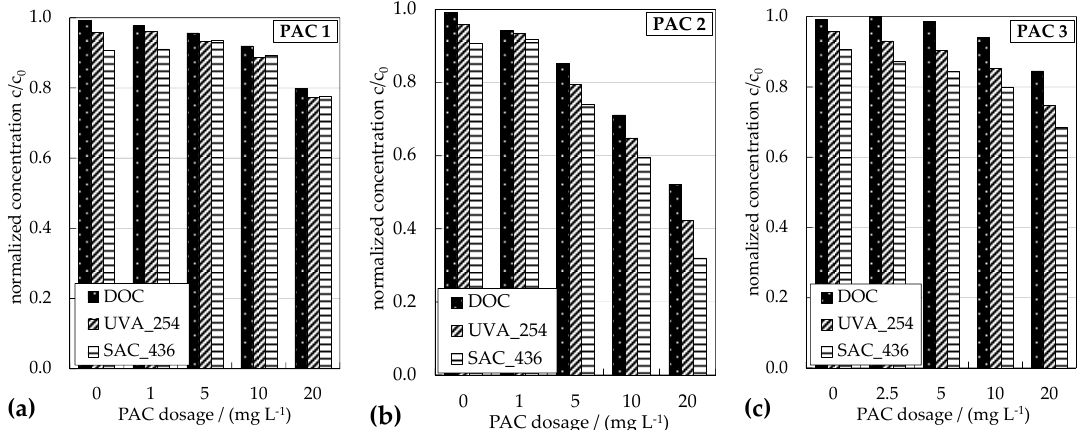
Figure 4. Ultrafiltration with pre-deposition of raw PACs in varying concentrations. Normalized average concentration of DOC, UVA 254 and SAC 436 dependent on applied carbon concentration of ( a ) PAC 1, ( b ) PAC 2 and ( c ) PAC 3. (Membrane: 150 kDa; PES; 2.87 × 10 − 3 m 2 ; V F = 500 mL; n = 2–3).